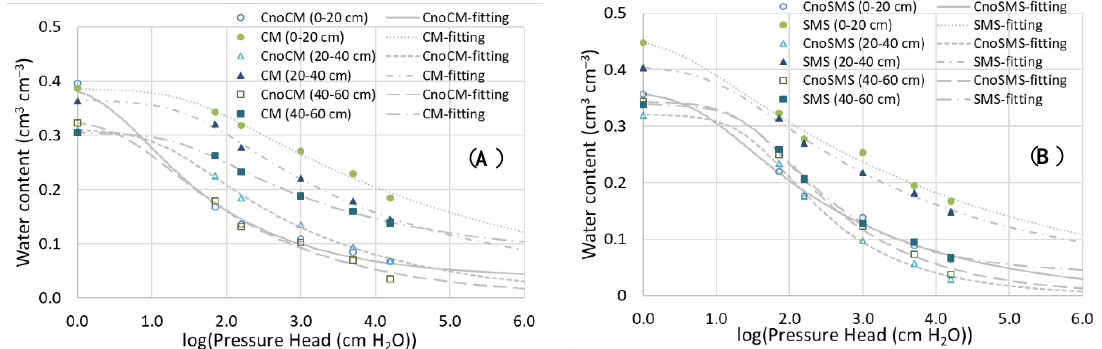
Figure 2. Fitted and measured soil water retention curves at depths of 0–20, 20–40, and 40–60 cm. CM—chicken manure ( A ), SMS—spent mushroom substrate ( B ), CnoCM—control for the CM-amended soil, CnoSMS—control for the SMS-amended soil substrate (SMS).